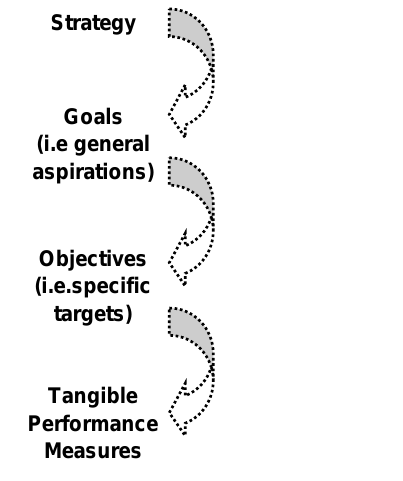
Figure 3. Strategic nature of performance goals (Macário,